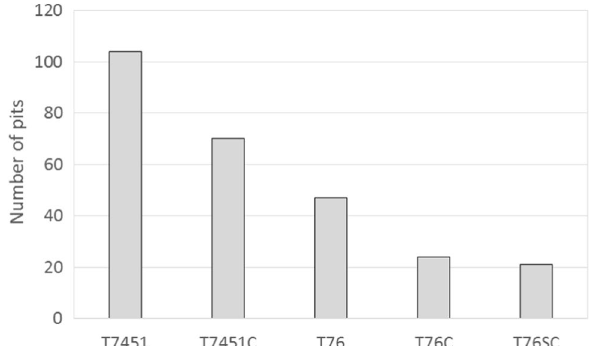
Fig. 12 Comparison among the number of pits in all the heat-treating